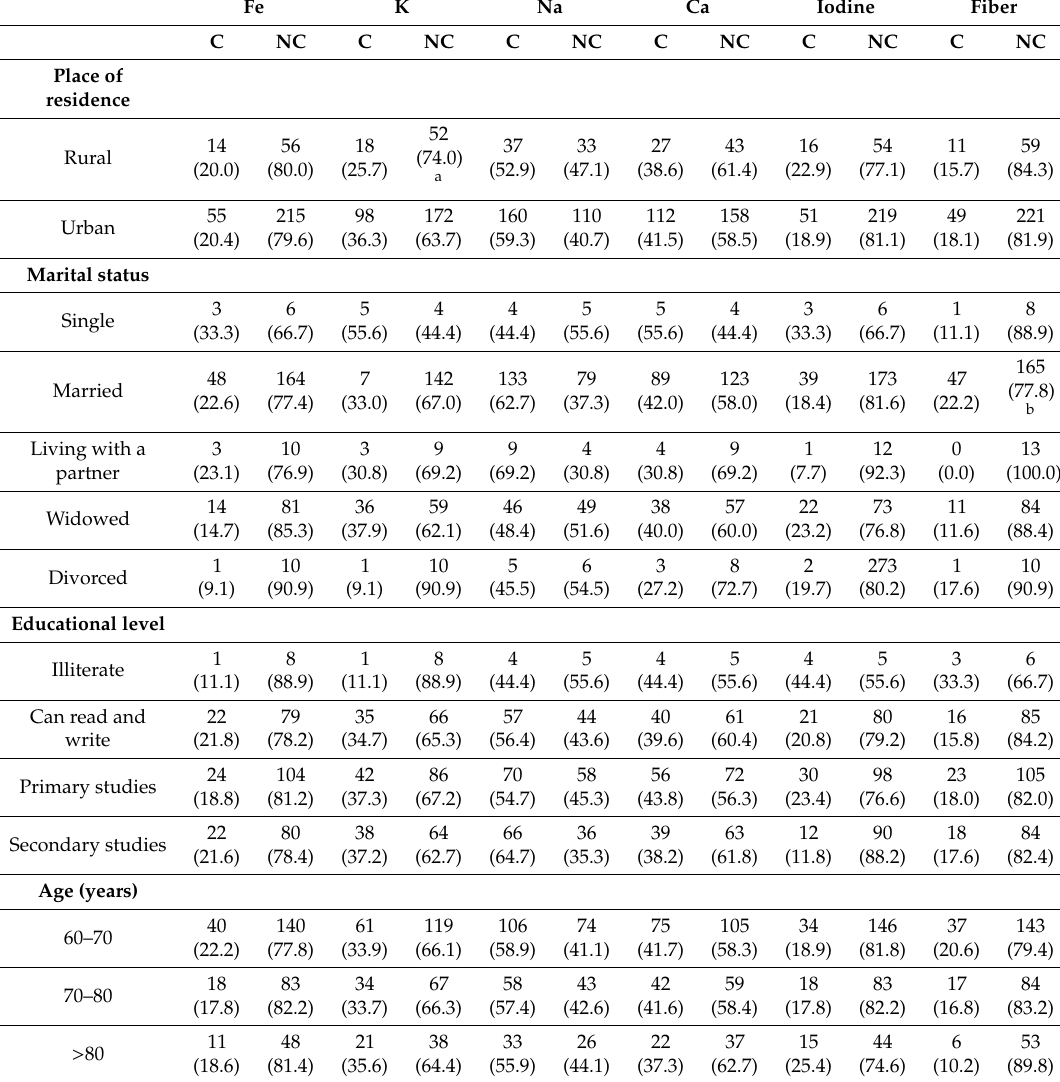
Table 5. Relationship between sociodemographic variables and compliance with mineral and fiber intake